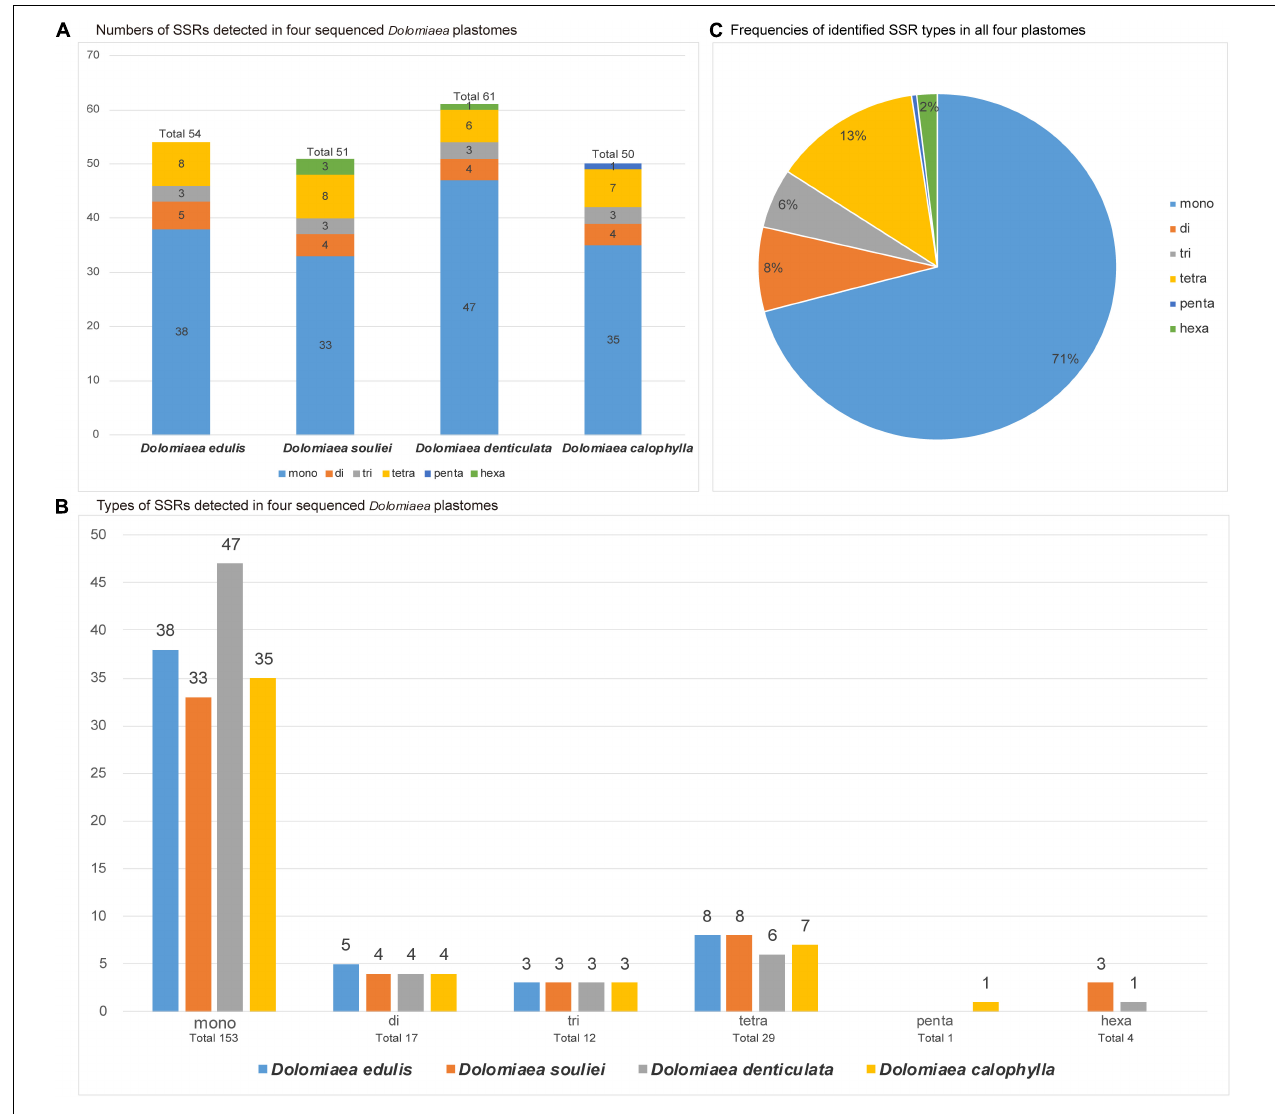
FIGURE 4 | Comparison of simple sequence repeats (SSRs) among four plastomes. (A) Numbers of SSRs detected in the four newly sequenced Cardueae plastomes. (B) Types of SSR types detected in all four plastomes. (C) Frequencies of identified SSR types in all four